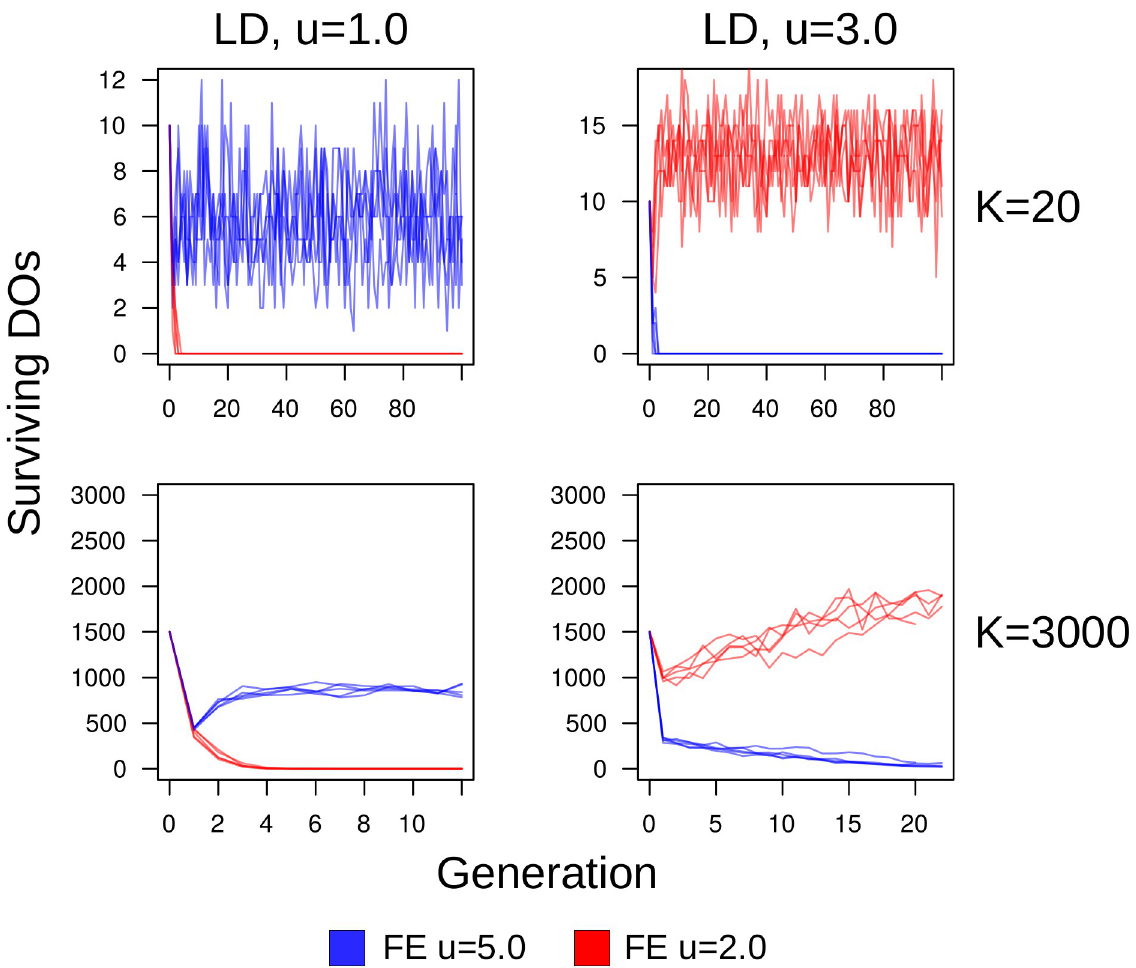
Fig 14. Competition between fixed Le´vy and Brownian foraging exponents. Competition simulations of equal-sized populations with fixed foraging exponents (denoted as FE), lifespans λ = 1M, and searching cost χ = 1/8000; Le´vy-like u = 2.0 (red) versus Brownian-like u = 5.0 (blue). The carrying capacity of the top row is K = 20 DOs, the bottom row is K = 3000 DOs. The left column is DOs traversing LD environments with dimension u = 1.0, and the right column is fractal dimension u =